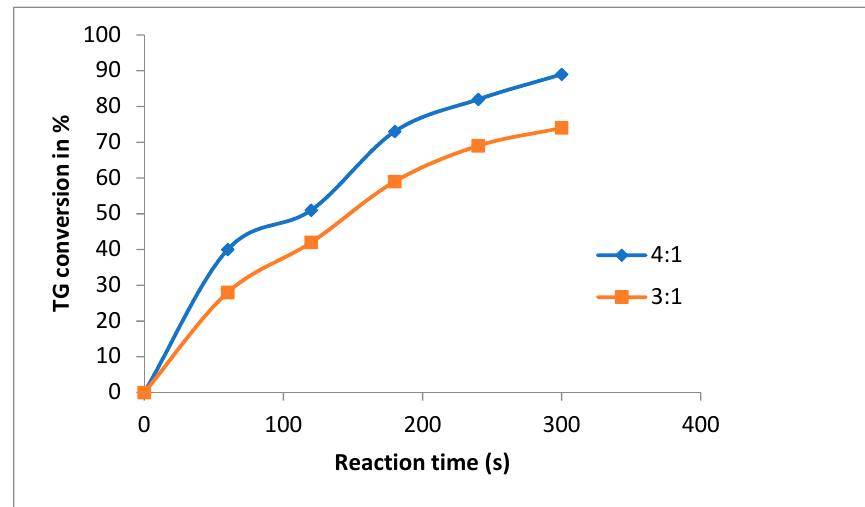
Figure 6. Ultrasound biodiesel production in batch reactor, catalyst (guanidine A) 3% mol, 4:1 and 3:1 (methanol: Canola oil) US 60% amplitude, 35 °C.